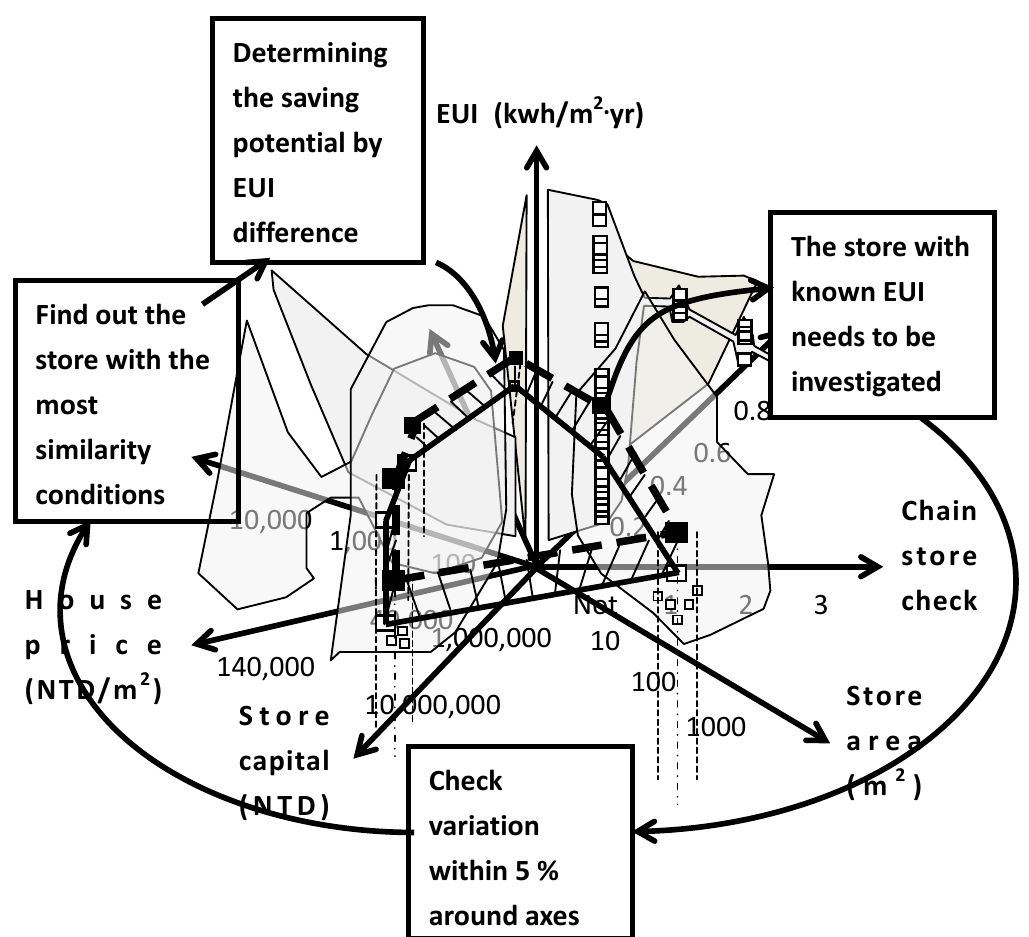
Figure 6. Similarity condition analysis as the second algorithm data array analyzer: data array is used to find out a reference which has the most conditions similar to the store under investigation. EUI comparison between sample and reference is the basic principal for investigating energy-saving potential on the cloud. Four blocks around the data array illustrate how to determine saving